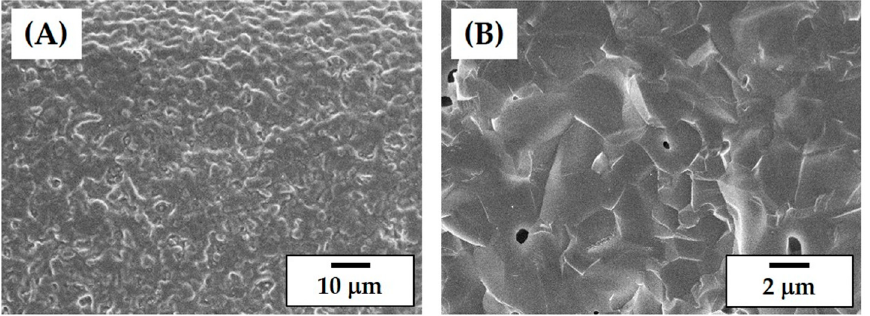
Figure 11. Representative FE-SEM images of ( A ) the free surface and ( B ) fracture surface of the CaP frameworks.